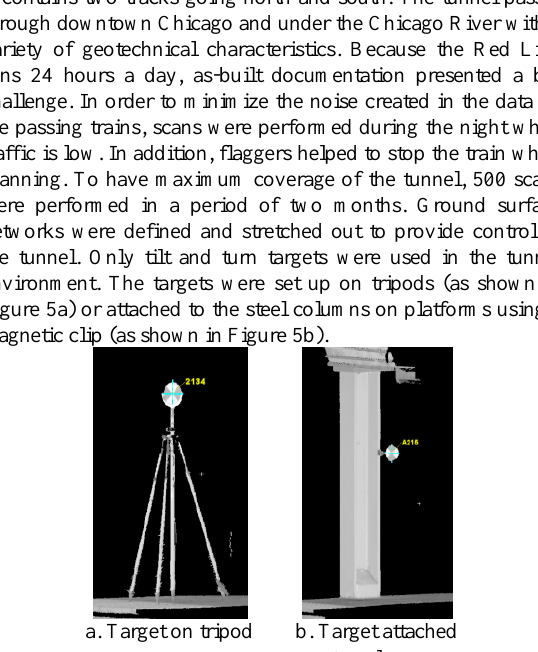
Figure 5. Location of targets